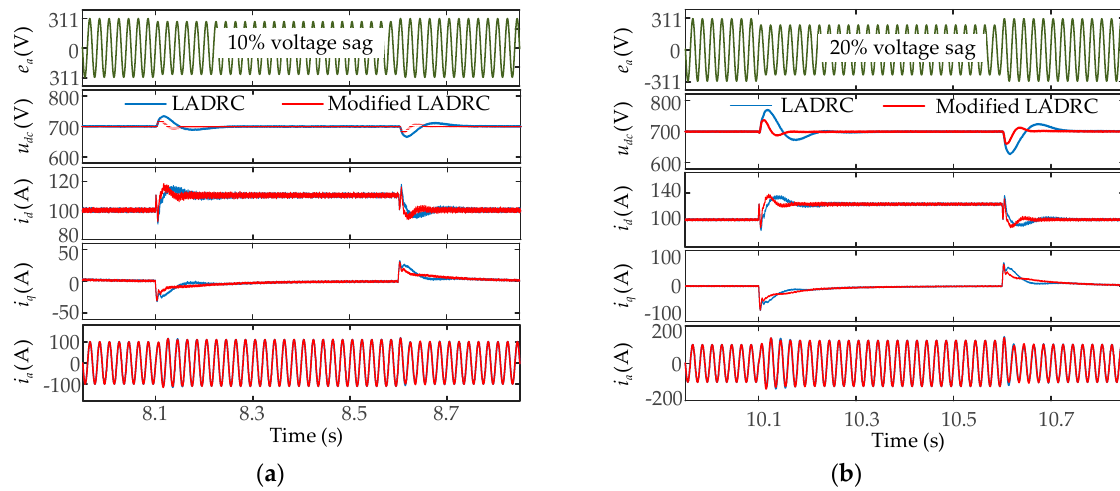
Figure 16. Robustness comparison under grid voltage sags: ( a ) 10% voltage sag on grid; ( b ) 20% voltage sag on grid.